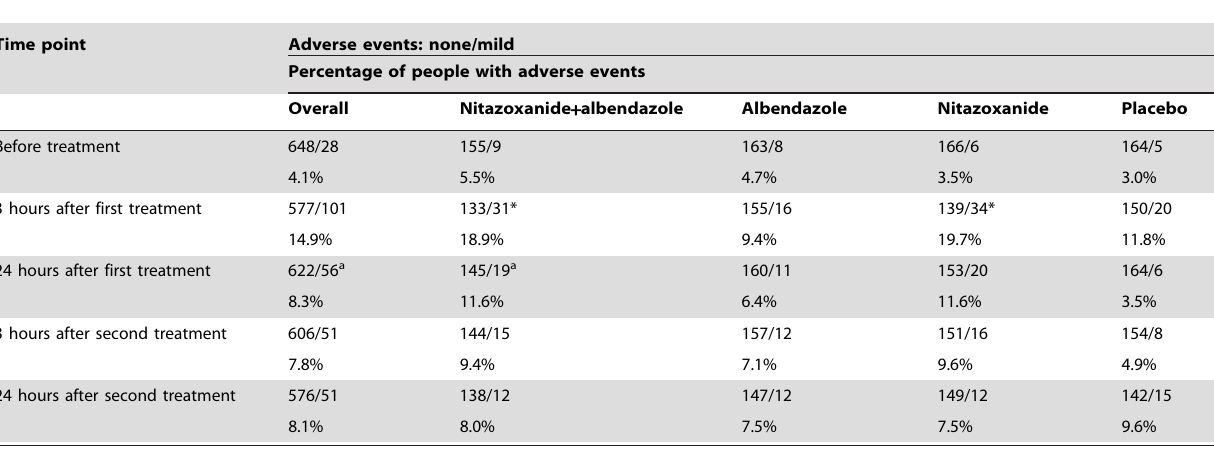
Table 3. Assessed adverse events among the four treatment arms during a randomized, placebo-controlled trial carried out on Pemba Island,